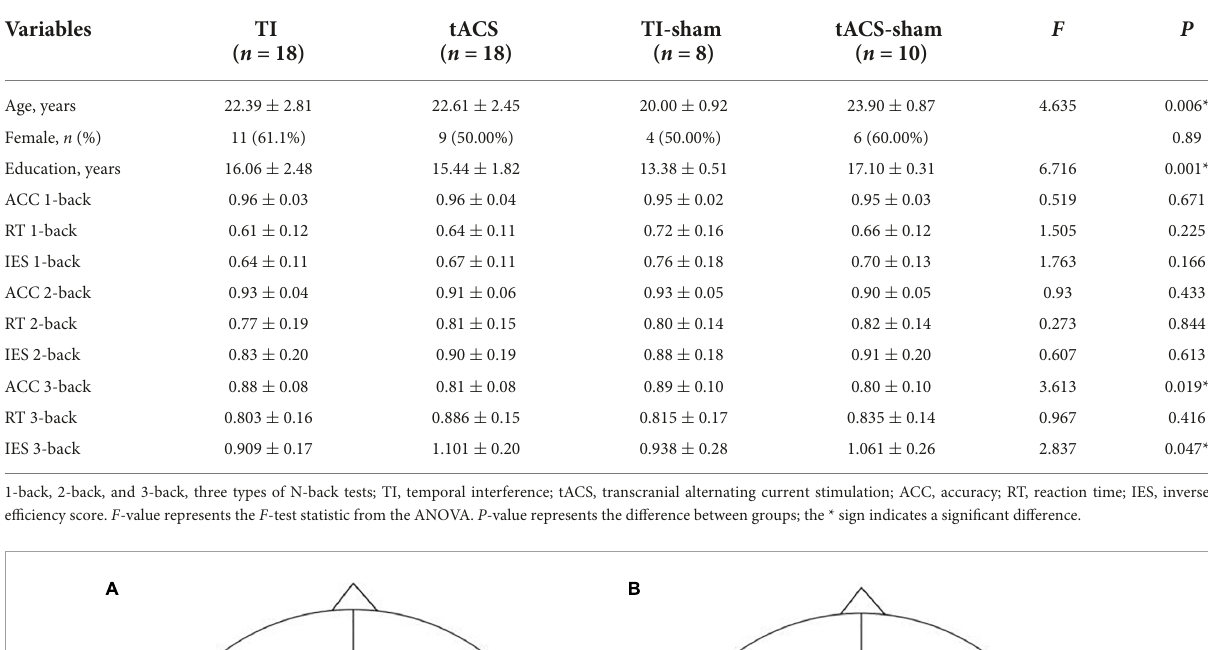
TABLE 1 The baseline characteristics of four groups (mean ± SD).